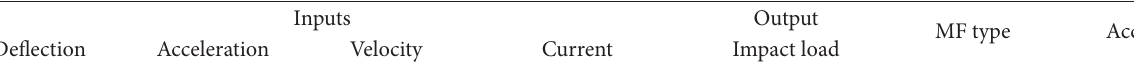
Table 4: Simulation parameter studies.